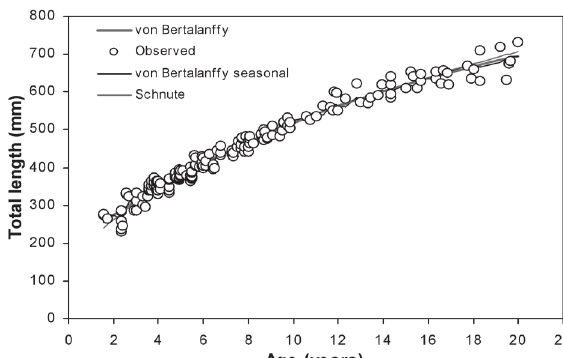
Table 2. – Parameter estimates for the von Bertalanffy growth model (VB), the schnute growth model (s), and the seasonalised